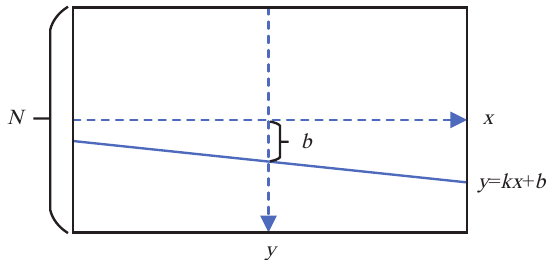
Figure 4. Sea–sky line in slope-intercept